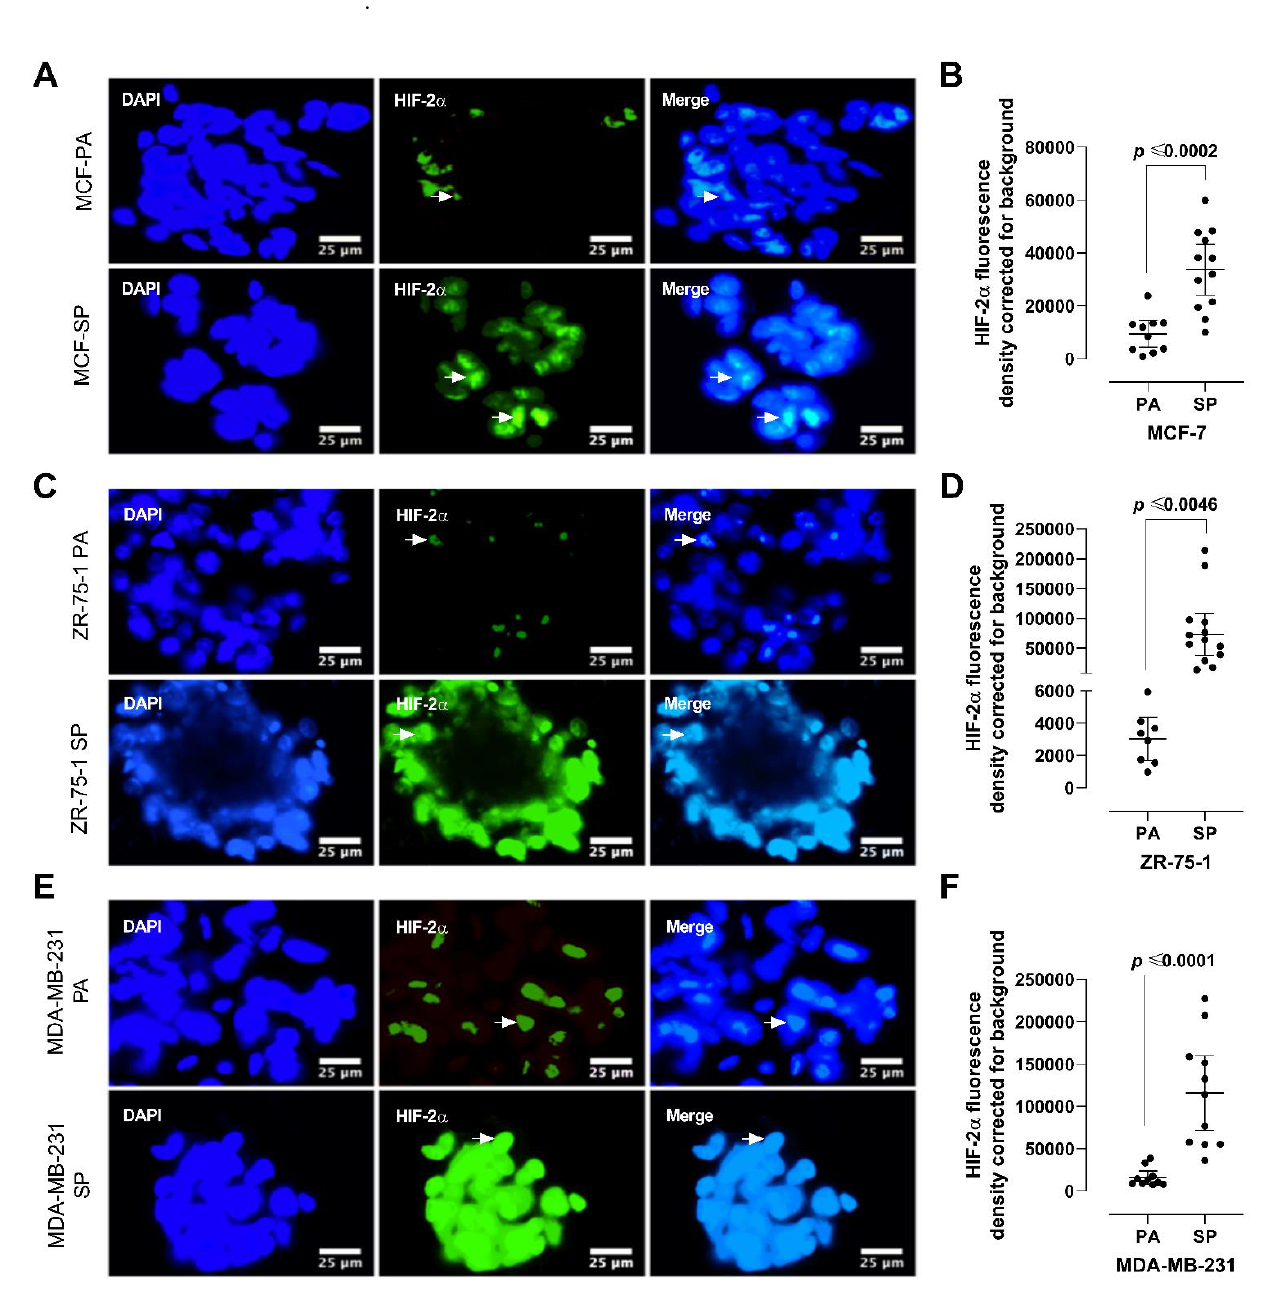
Figure 4. Analysis of 2D monolayer cells and 3D stem-like spheroids of MCF-7, ZR-75-1, and MDA-MB-231 breast cancer cells for HIF-2 α expression using immunocytochemistry. ( A , B ) MCF-7, ( C , D ) ZR-75-1, and ( E , F ) MDA-MB-231 breast cancer cells were cultured as monolayers and 3rd generation spheroids and incubated with primary antibody against HIF-2 α (1:100), followed with AlexaFluor 488 conjugated secondary antibody (1:100). Cells were counterstained by DAPI to visualize the nuclei. Coverslips were mounted in PBS/glycerol and examined by epifluorescence microscopy (scale bar represents 25 µ m). The results are depicted as a scatter plot, where dots represent the indicated marker values of cells obtained from the representative of two independent experiments of multiple cell images ( n = 7–16). The mean fluorescence density staining corrected for background ± SEM for indicated marker values is indicated for each group. The density staining HIF-2 α values of each SP group were compared to the PA group using the unpaired two-tailed t -test comparisons with 95% confidence with indicated statistical significance. Abbreviations: PA, parental; SP, spheroid; PBS, phosphate-buffered saline; DAPI, 4 (cid:48) ,6-Diamidine-2 (cid:48) - phenylindole